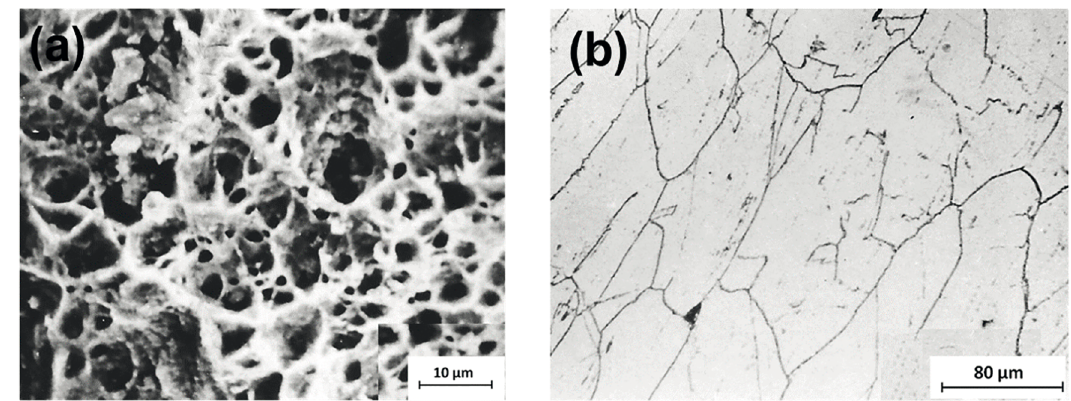
Figure 3. Ruptured tip of investigated 316 steels at 700°C: (a) SEM fractograph of SS1 steel with RA = 75% under stress of 180 MPa and (b) OM of SS2 steel with RA = 60% under 190 MPa.